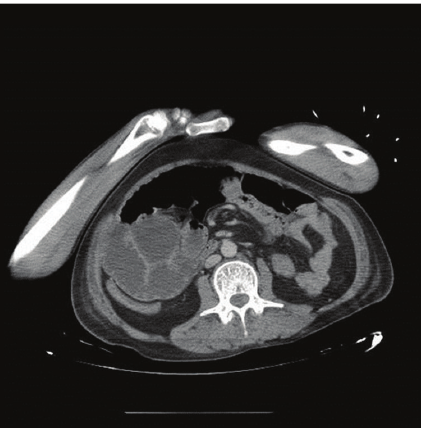
Figure 1: Dilatation of the ascending colon and diffuse thickening of the walls of the transverse colon, which shows partial stenosis and inflammatory changes in the adjacent